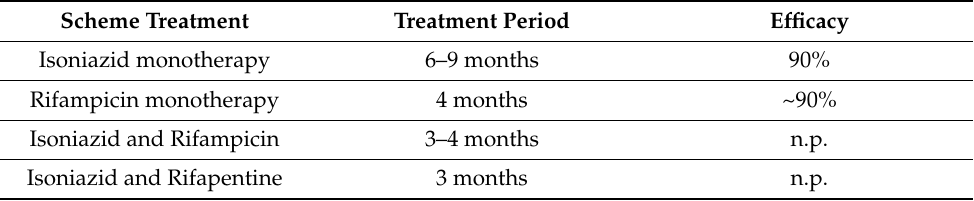
Table 4. Recommended treatments against latent tuberculosis infection (LTBI) and its efficacy in preventing progression to active tuberculosis